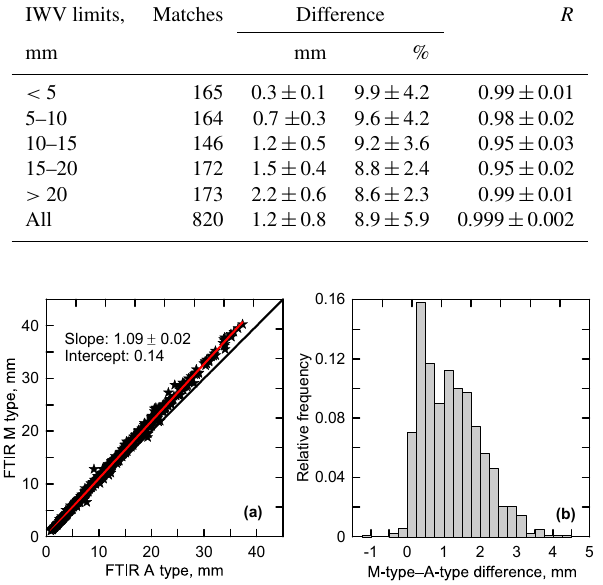
Figure 5. Correlations of synchronised IWV pairs: the M type vs. A type (a) . Histogram of distribution of absolute differences: the M type minus A type (b) . Red line is the linear regression